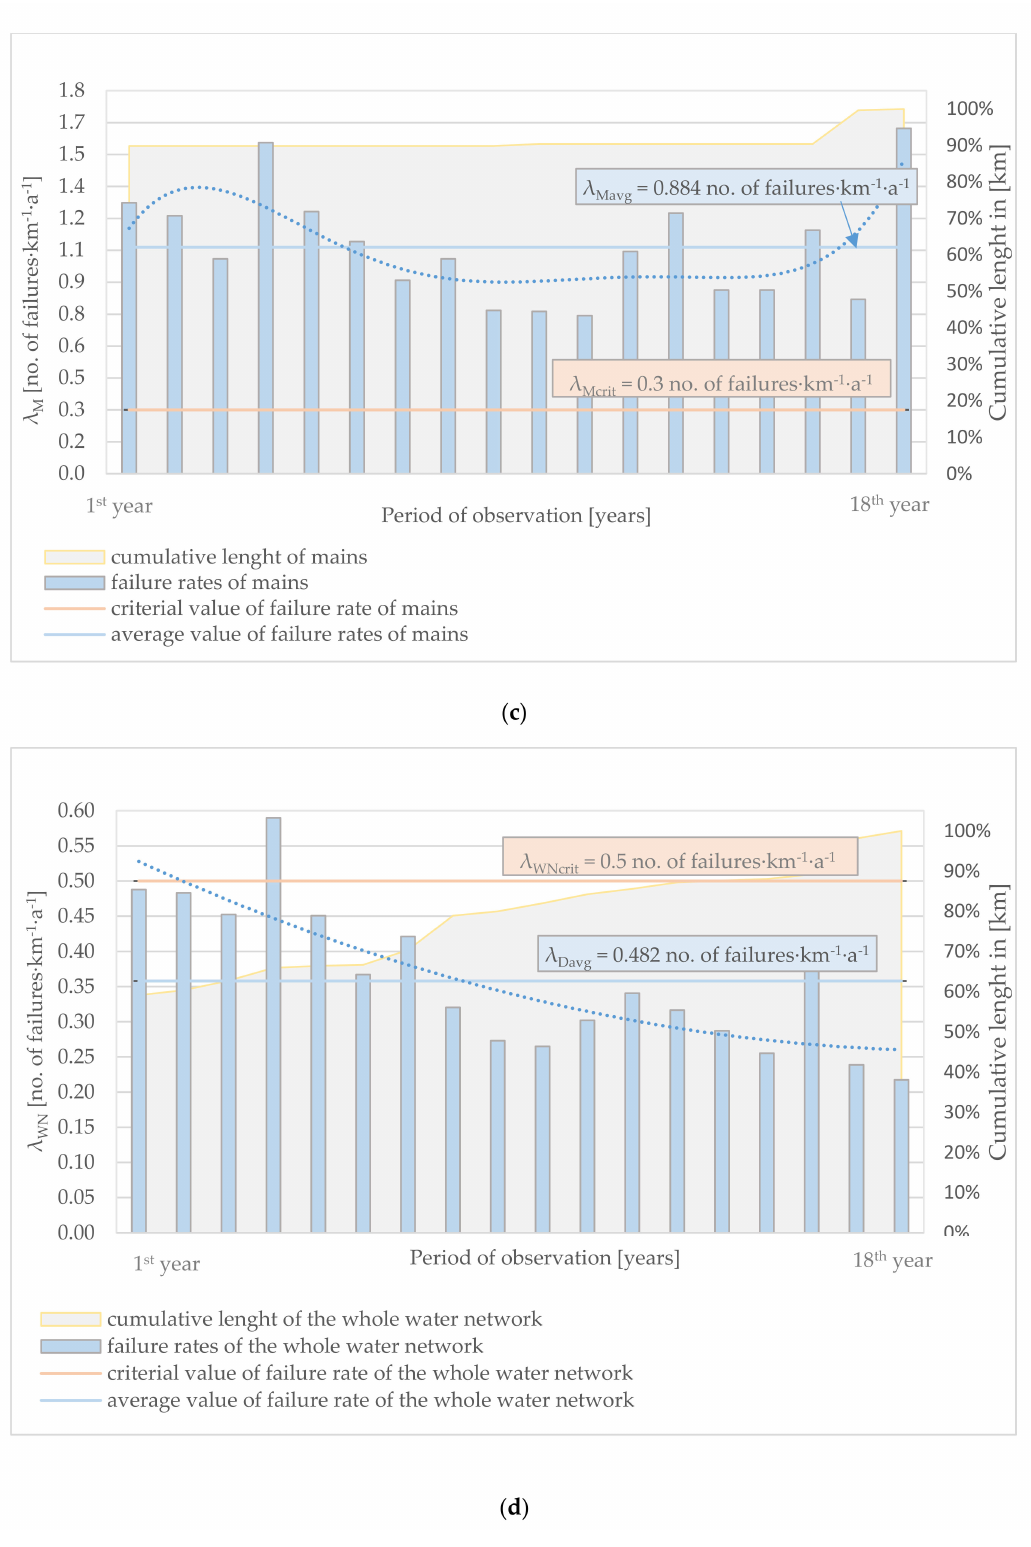
Figure 1. The failure rate in each year of the analysis: ( a ) distribution pipes, ( b ) water connections, ( c ) mains, and ( d ) the whole water